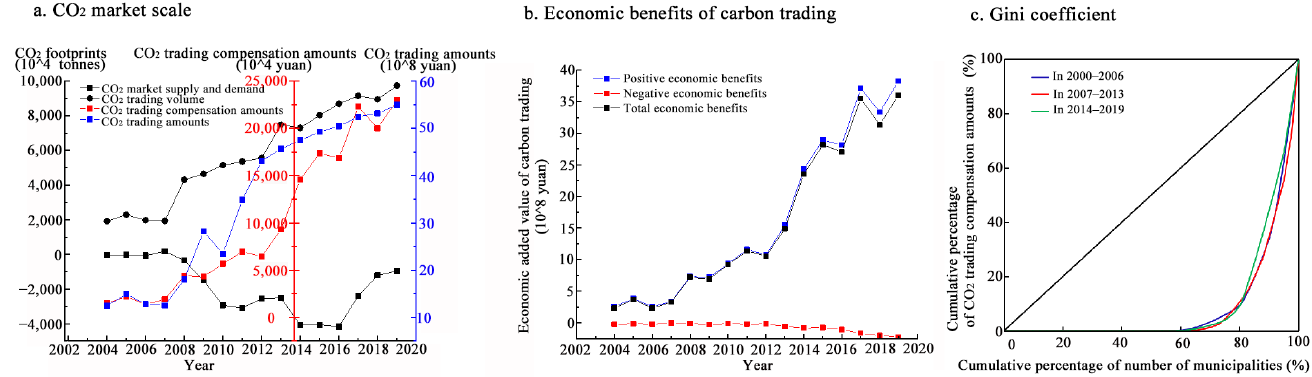
10. Evolution of supply–demand relationship and economic benefits in CO 2 trading of the